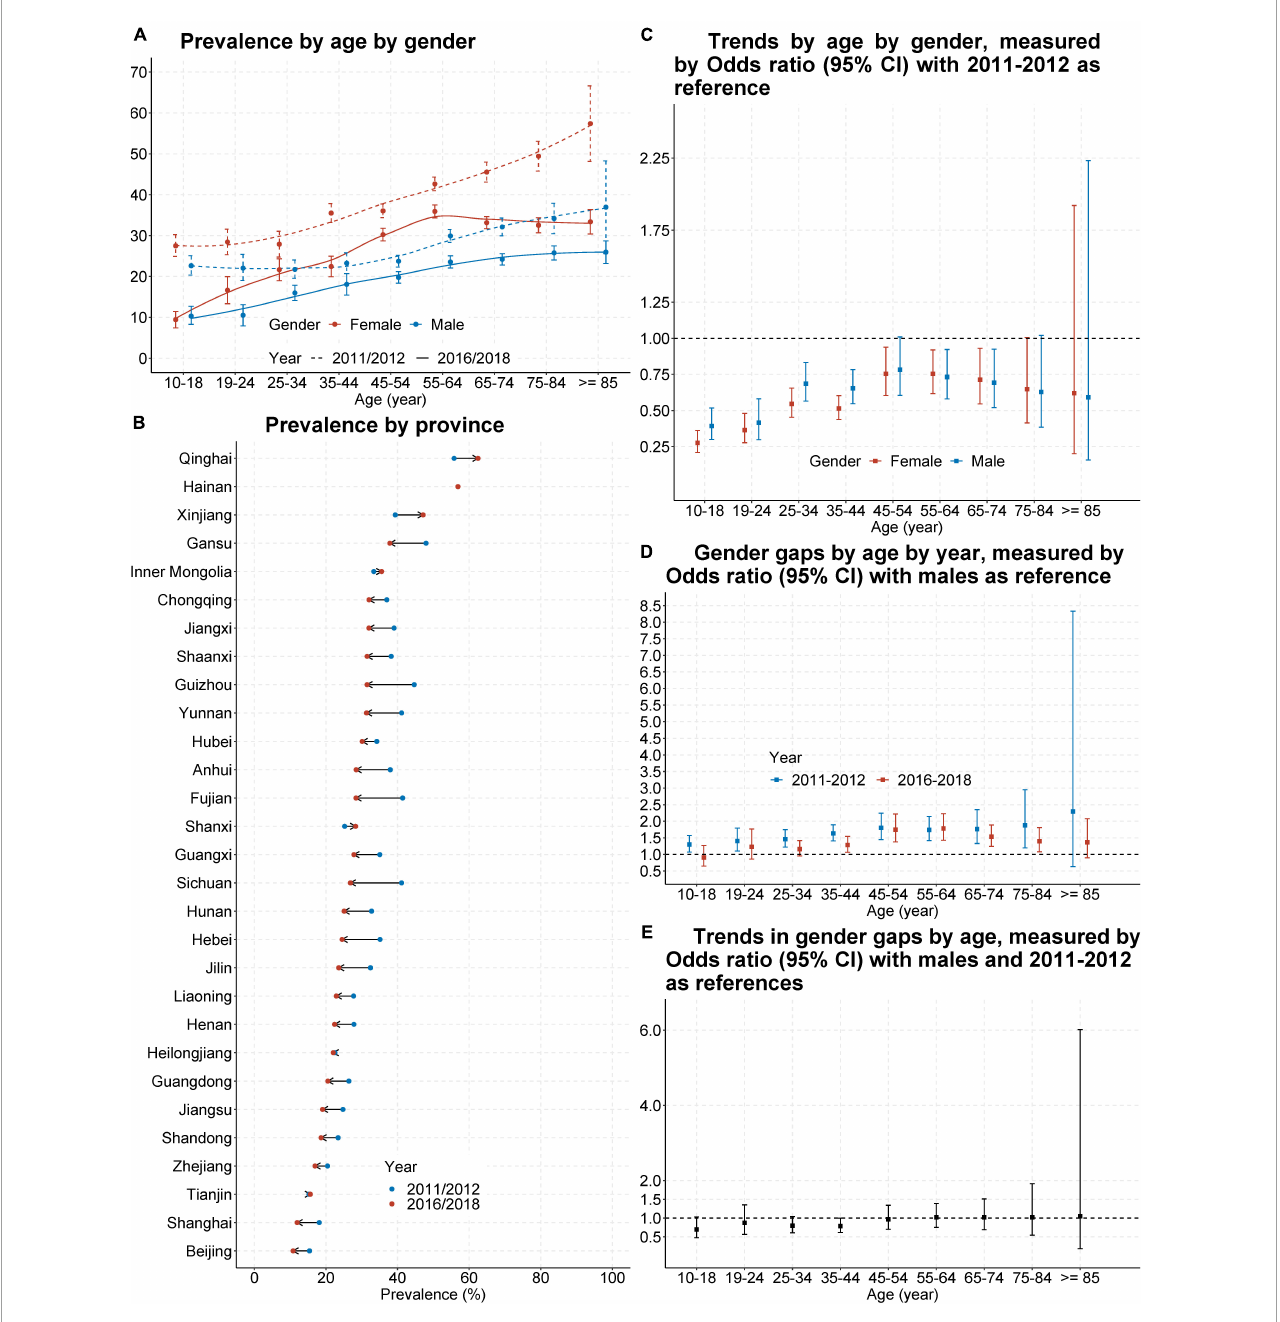
FIGURE1 Prevalence and trend of those who screen positive for depression in China, from 2011–2012 to 2016–2018. Shown is the prevalence of populations who screen positive for depression in China by age and gender (A) or by sampled provinces or cities (B) . Also shown are odds ratio and its 95% confidence interval (CI) for trend of this prevalence by age and gender (C) , gender gap of this prevalence by age and study year (D) , and for the change of gender gap by age (E) . Odds ratio and its 95% CI was estimated from survey-specific weighted regression models and then pooled by meta-analysis. Odds ratio > 1 means the prevalence higher in females (D) or during 2016–2018 (C,E)